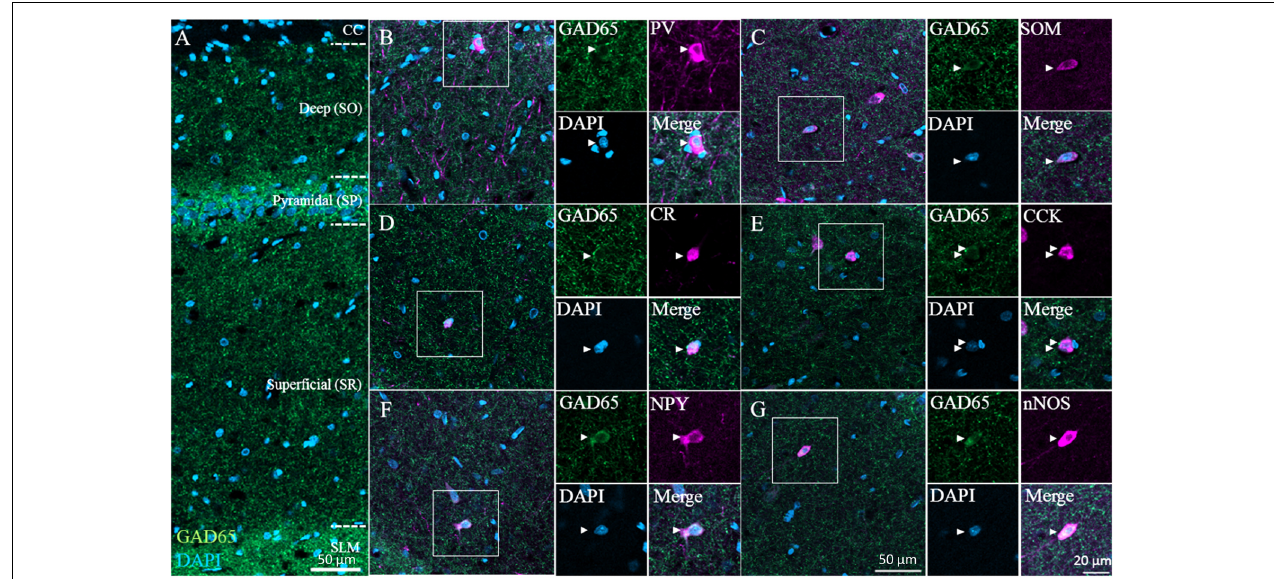
FIGURE 4 | GAD65 expression in each GABAergic subtype in the hippocampus. Double immunofluorescence image showing GAD65 (green) and DAPI (blue) signals (A) . Triple immunofluorescence images showing GAD65 expression (green); positive signals for PV, SOM, CR, CCK, NPY, or nNOS (magenta); and DAPI staining (blue) in the superficial (SR) layer (B–G) . White squares indicate the regions enlarged in the panels on the right, and arrowheads indicate somata. CC, corpus callosum; SO, stratum oriens; SP, stratum pyramidale; SR, stratum radiatum; and SLM, stratum lacunosum-moleculare.